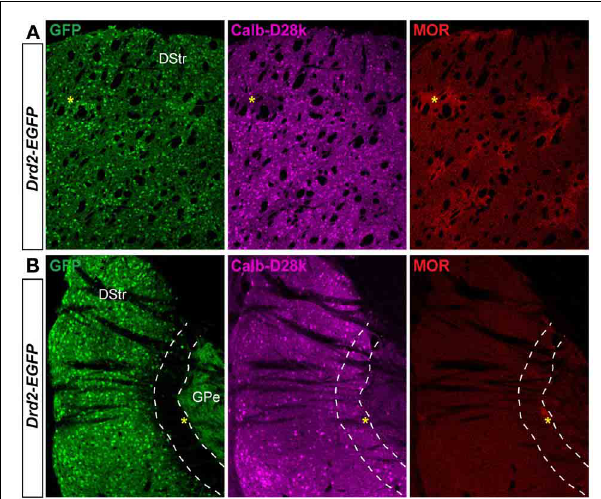
FIGURE 7 | Patch/matrix organization in the D2R/A2aR-expressing MSNs-poor zone of the caudal striatum. Striatal sections at the rostral (A) and the caudal (B) level from Drd2-EGFP mice ( n = 3) labeled with antibodies for calbindin-D28k (Calb-D28k, middle panel) and μ opioid receptor (MOR, right panel) to identify matrix and striosome compartments, respectively. Note the presence of dense MOR staining identifying striosomes in the rostral part of the striatum (yellow asteriks). Scale bars, 200 μ m. DStr, dorsal striatum; GPe, external globus pallidus, GFP, green fluorescent